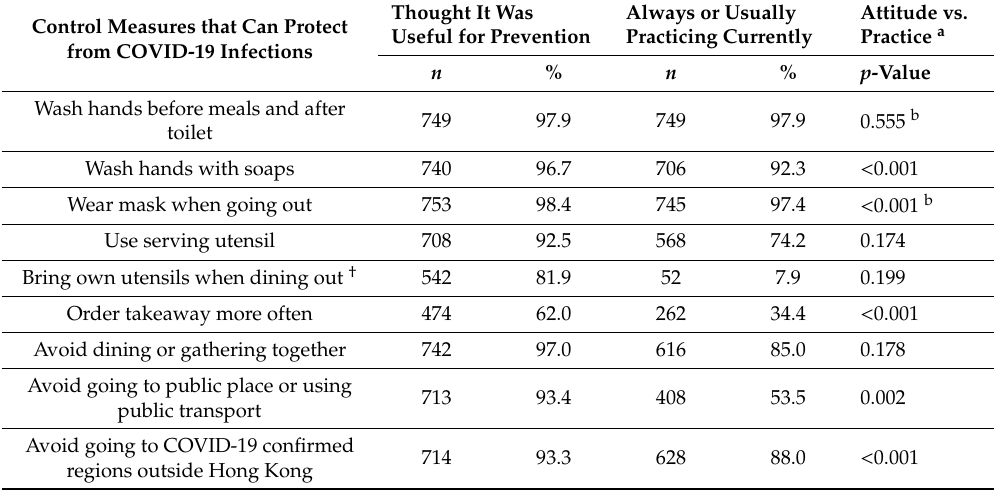
Table 2. Perceived usefulness and practice of preventive measures against